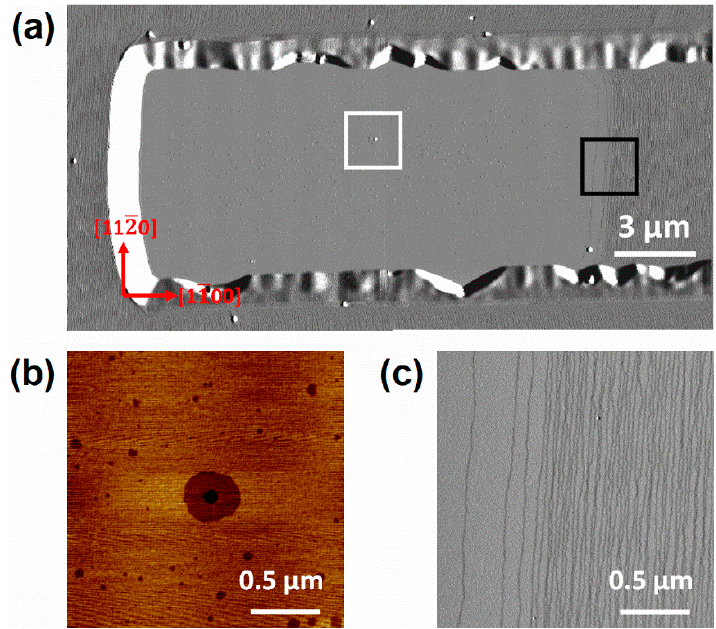
Figure 6. Large-scale AFM amplitude images (24 × 12 μ m 2 ) on the upstream edge of 10 μ m-wide stripe along the m-direction for sample B ( a ) and its 2 × 2 μ m 2 amplification image; ( b ) height image of white square; ( c ) amplitude image of the black square.